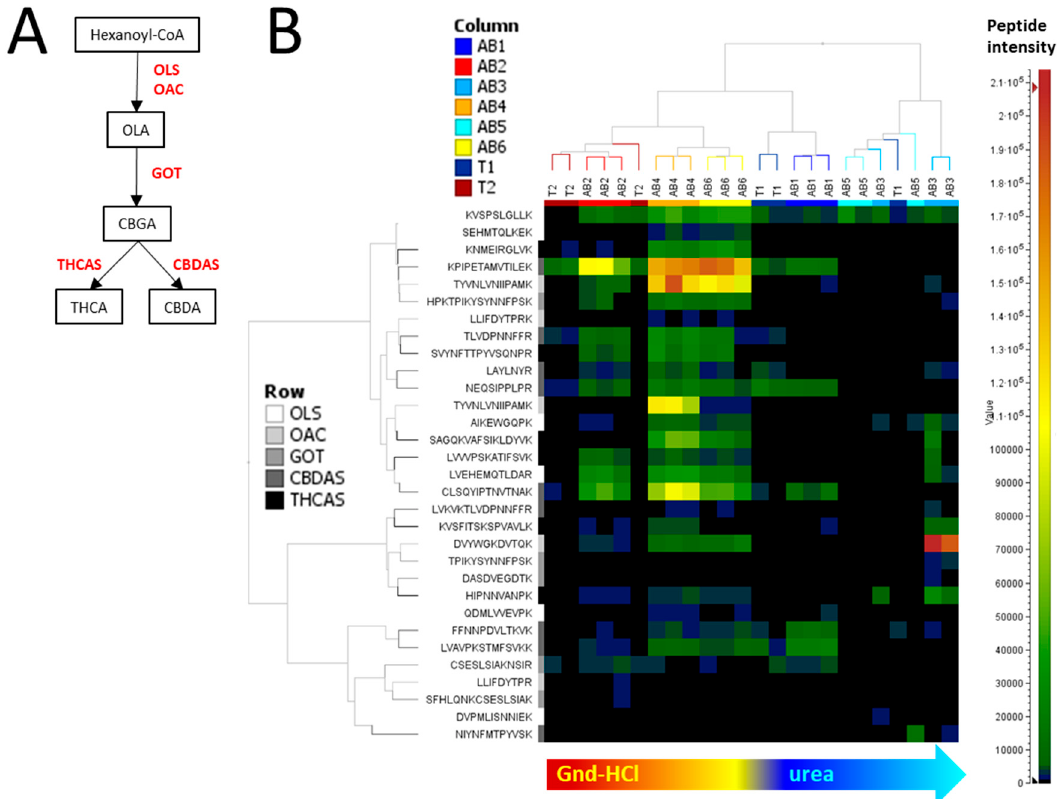
Figure 6. Impact of extraction methods on enzymes involved in cannabinoid biosynthesis identified by bottom-up proteomics. ( A ) Cannabinoid pathway. Enzymes in red were identified in this work. ( B ) Two-dimensional hierarchical clustering of enzymes involved in cannabinoid synthesis. Columns represent extraction method per tissue types (AB, apical bud; T, trichomes. See Column legend as well) and rows represent the peptides identified from enzymes of interest. Peptides from the same enzymes bear the same shade of grey (see Row legend as well). CBDA, Cannabidiolic acid; CBDAS, CBDA synthase; CBGA, Cannabigerolic acid; GOT, geranyl-pyrophosphate-olivetolic acid geranyltransferase; OAC, Olivetolic acid cyclase; OLA, Olivetolic acid; OLS, 3,5,7-trioxododecanoyl-CoA synthase;